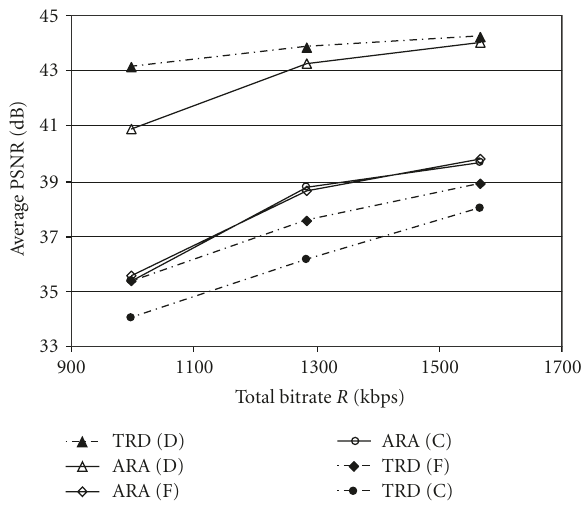
Figure 7: Individual R-D curves for the Carphone (C), Foreman (F), and Mother-Dauther (D) sequences obtained with M =